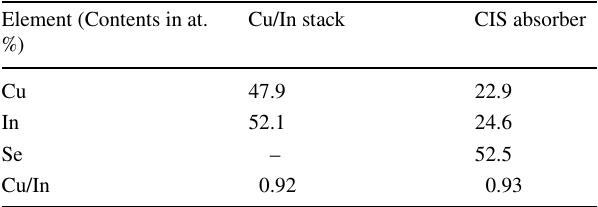
Table 1 Atomic composition of pulse electrodeposited Cu/In stack and selenized CIS absorbers, obtained from EDS analysis Element (Contents in at. %)